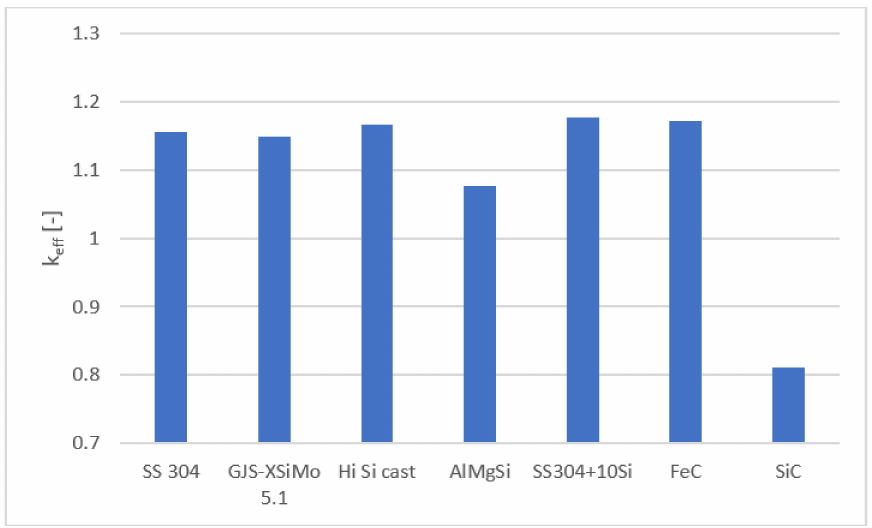
Figure 6. Analysis of the effect of a 30 cm thick reflector made from different silicon- and carbon-rich materials on the criticality of the studied 2D test